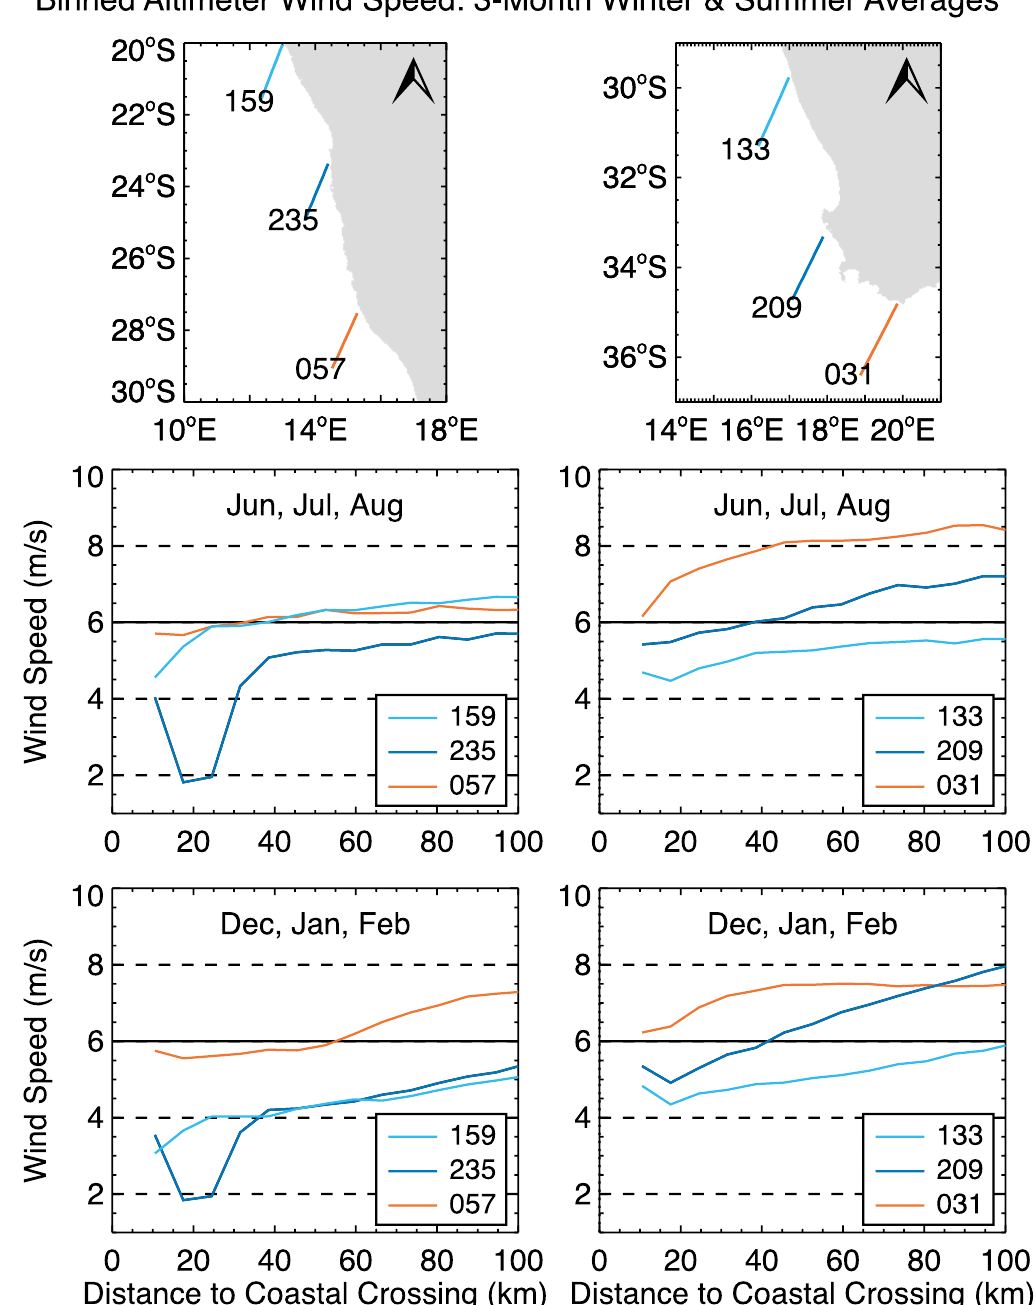
Figure 3. ( Top ) Locations of the six altimeter tracks for the northern and southern regions off southwest Africa, along with 28-year (1993–2020) averages of winter ( Middle ) and summer ( Bottom ) altimeter-derived wind speeds retrieved along 7-km sections of the tracks. The x-axis shows the along-track distance to the coastal crossing. Values for the 0–7 km bin closest to the coast are not shown.